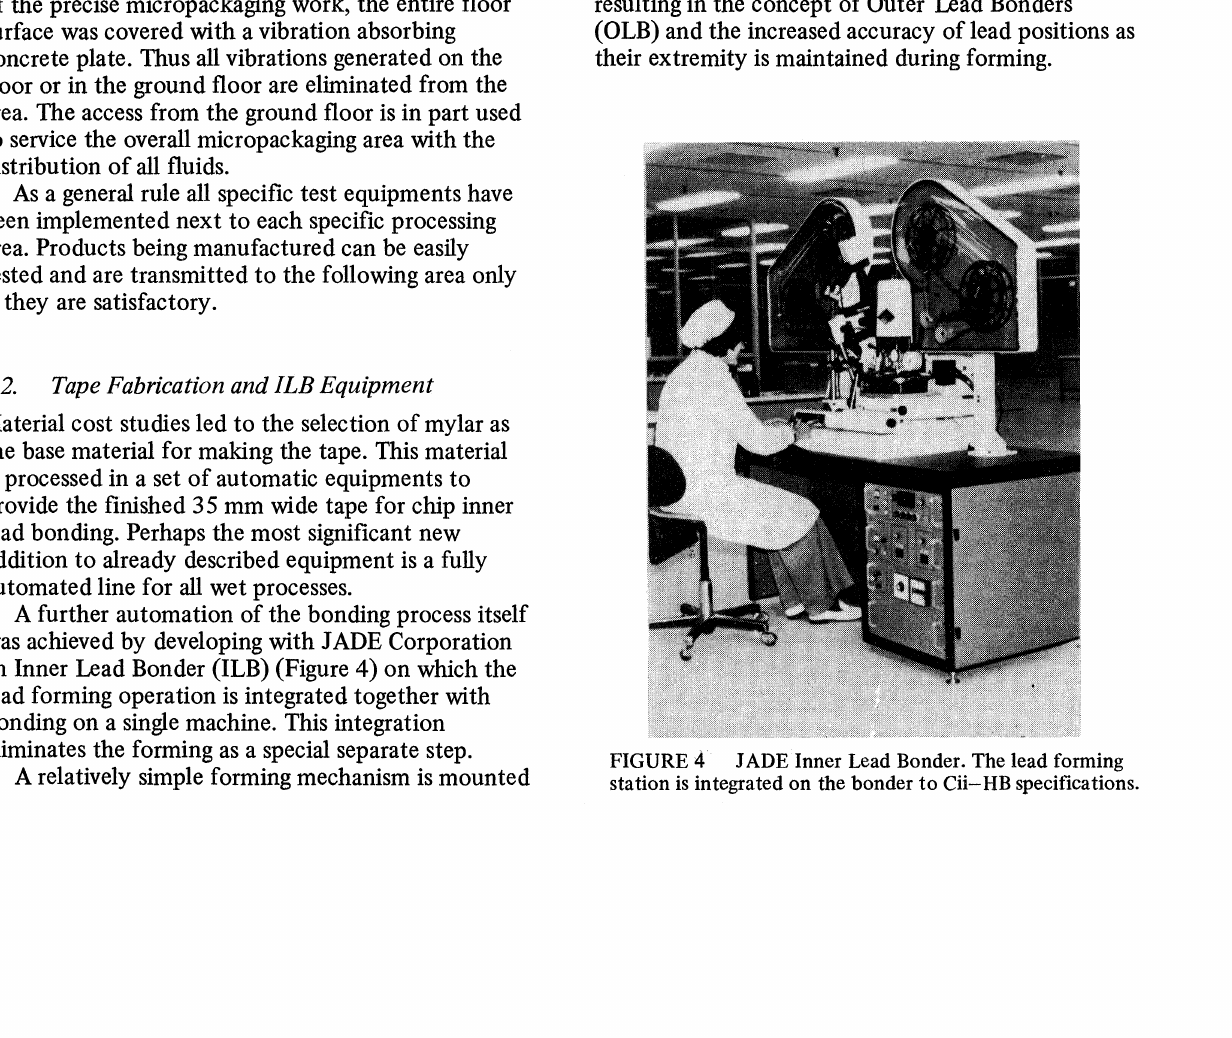
Lay-out of the micropackaging manufacturing facility. Total area is 1300 m Solid lines represent trans- parent glass walls, dashed lines represent theoretical boundaries between communicating areas.